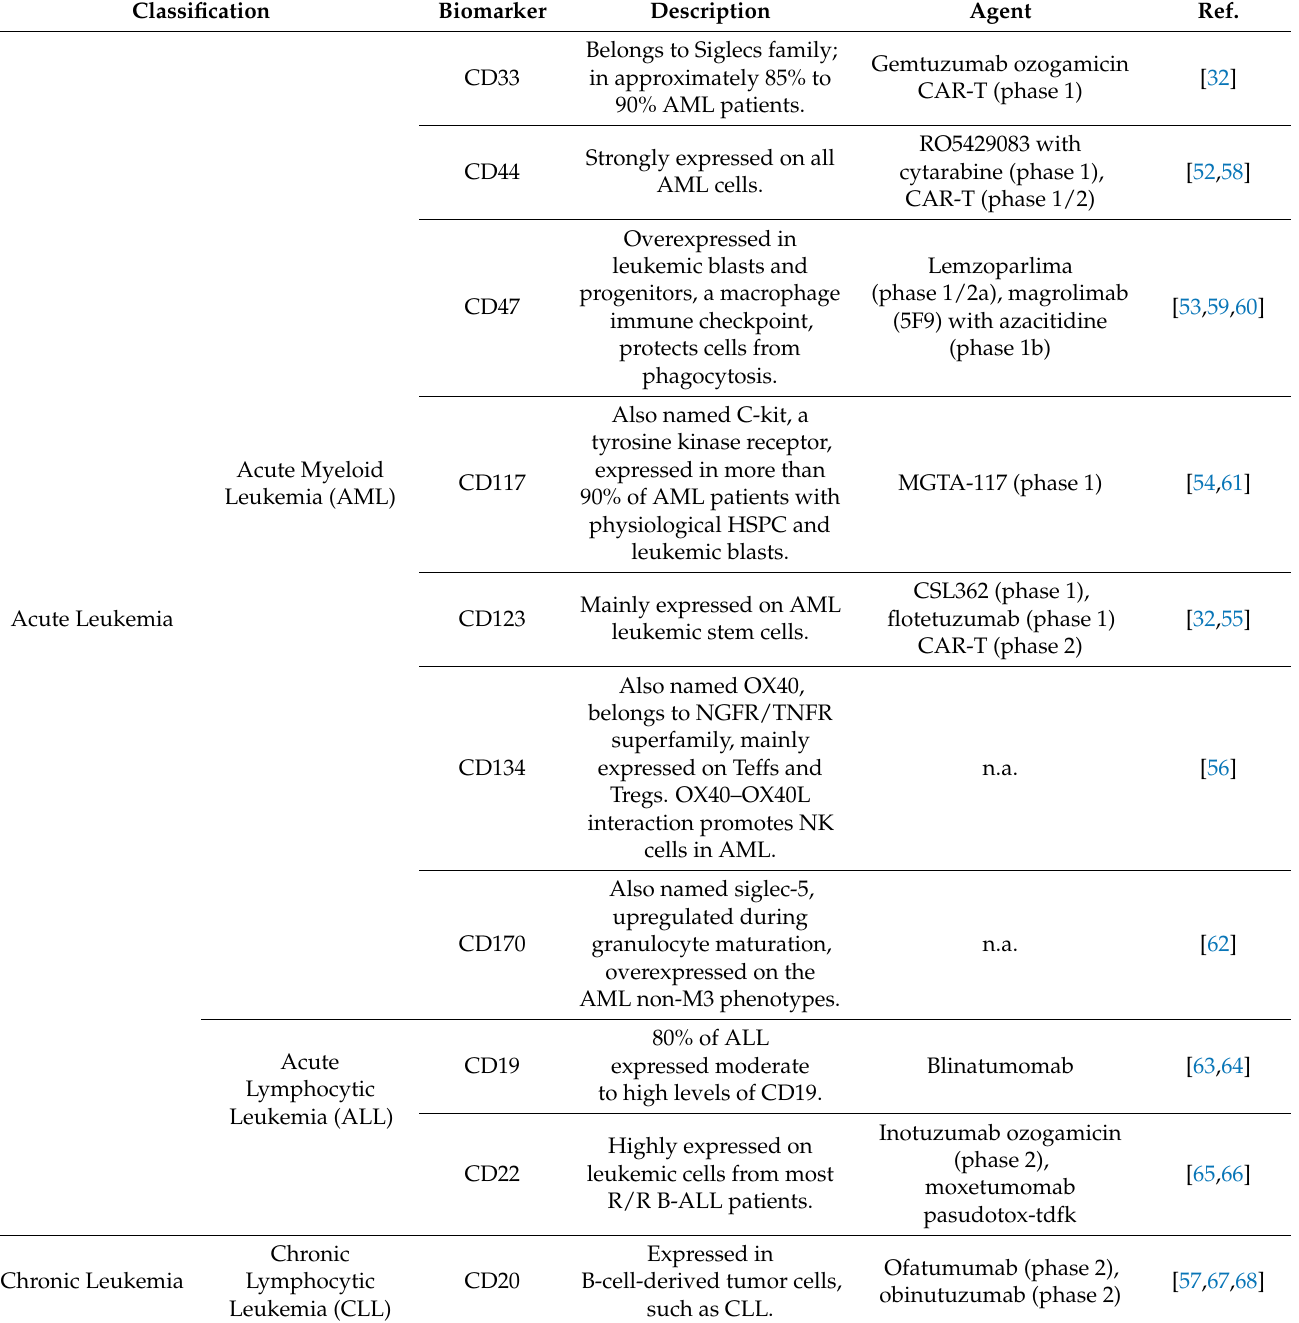
Table 1. CD markers as therapeutic target for leukemia